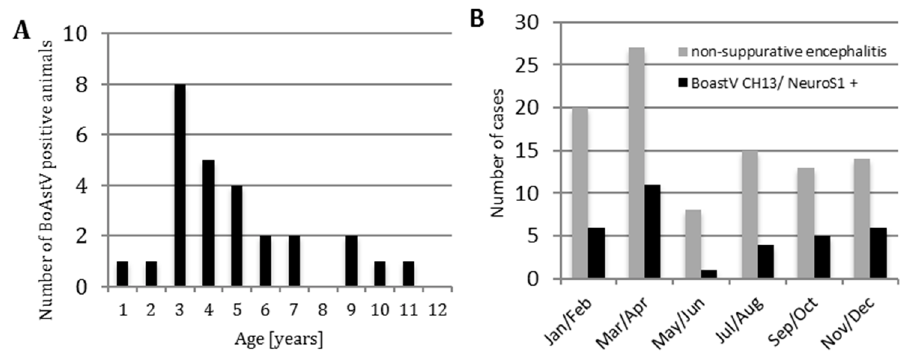
Figure 2. Age distribution ( A ) and seasonal distribution ( B ) of BoAstV CH13/NeuroS1 positive cases.